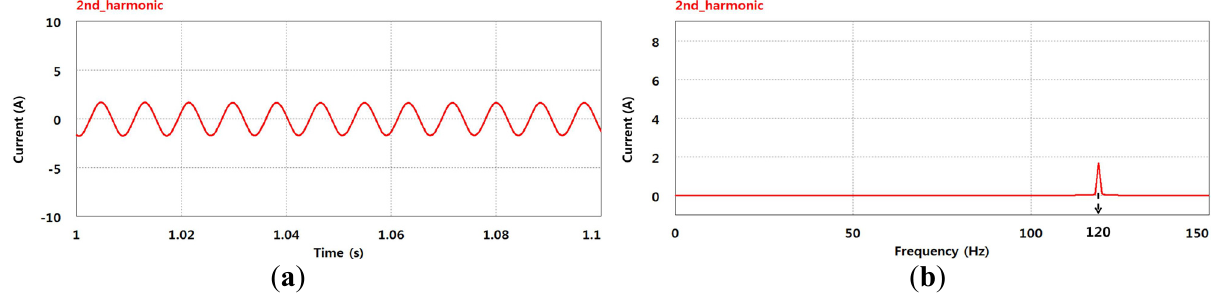
Figure 15. Simulation waveform of the second-order harmonic component. ( a ) Time domain; ( b ) frequency domain.